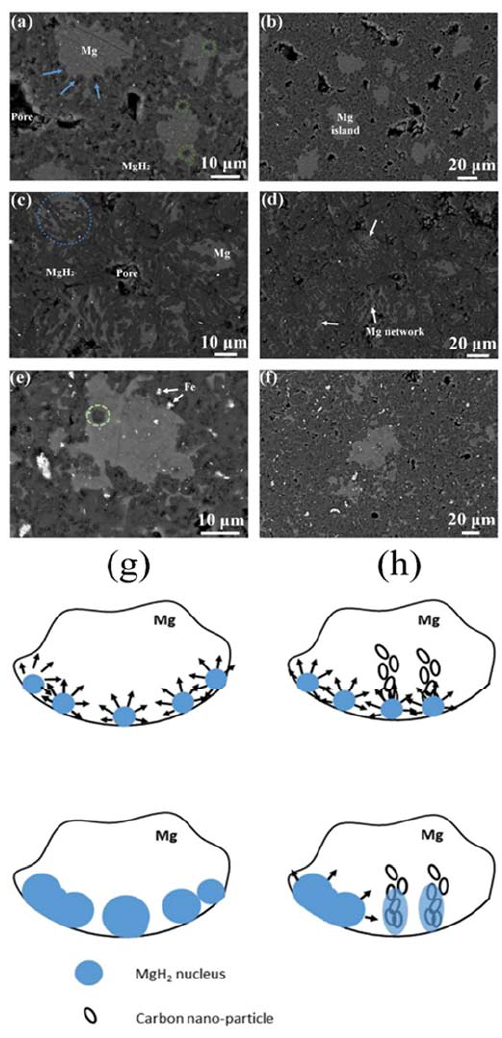
Figure 10. BSE micrographs of the pellets hydrogenated to 80–90% of maximum theoretical hydrogen